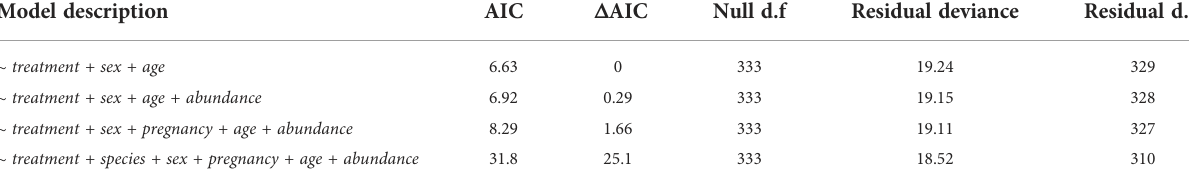
TABLE 4 Logistic regression model selection table comparing top four models based on lowest AICc. Model